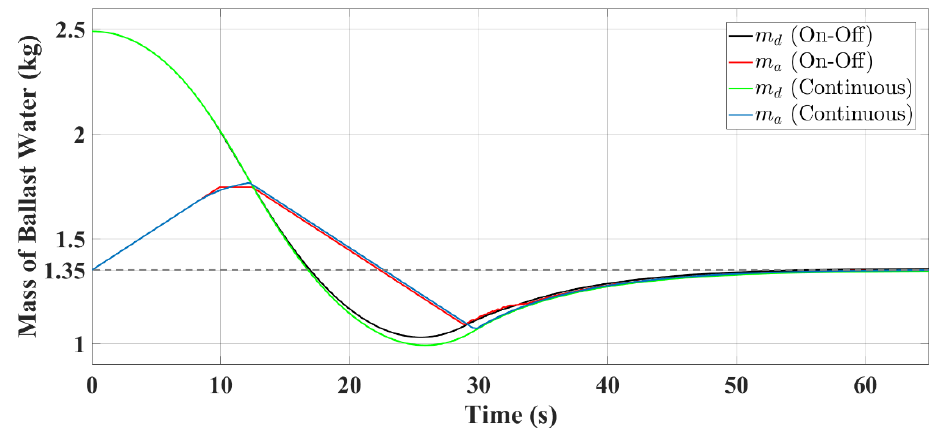
Figure 6. Demanded and actual ballast mass changes of on-off and continuous type VBS control.